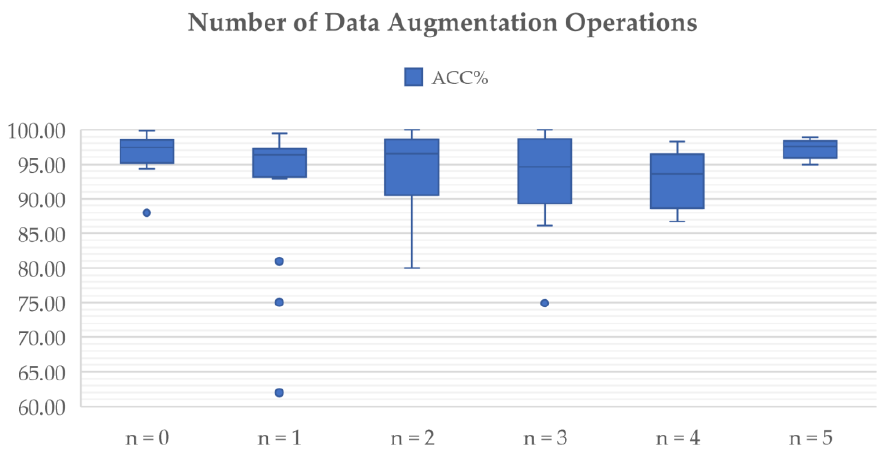
Figure 13. Classification accuracy by number of data augmentation operations.